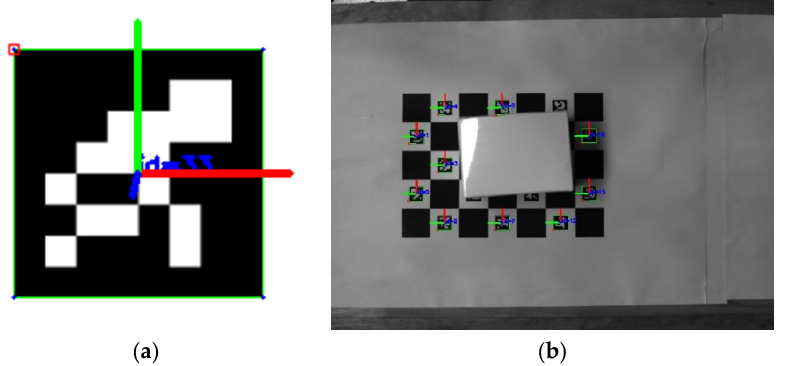
Figure 5. ( a ) The pose of the ArUco marker in the camera coordinate system; ( b ) The pose of each recognizable coding pattern of the ChArUco board in the camera coordinate system.